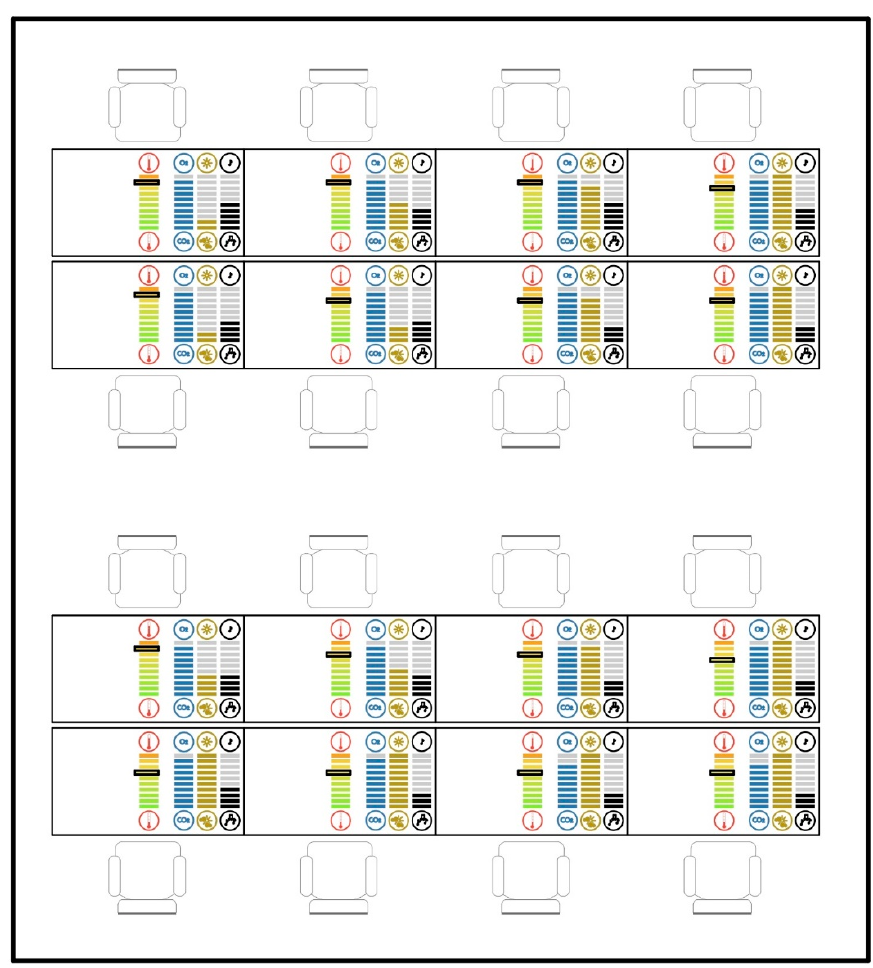
Figure 5. The comfort map.